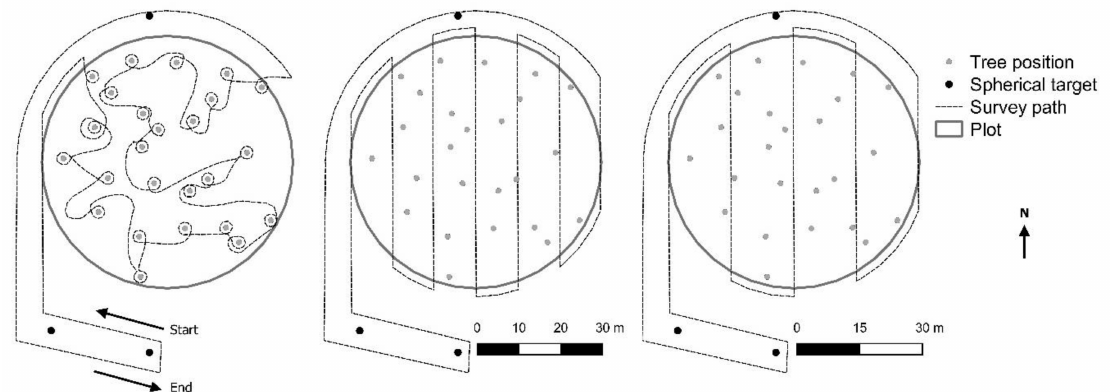
Figure 2. Survey paths used for the scans with HMLS (ZEB1): walking with the instrument around each tree (D0 scan, left), and walking back and forth along straight lines drawn at a distance of 10 m (D10 scan, center) and 15 m (D15 scan, right) from each